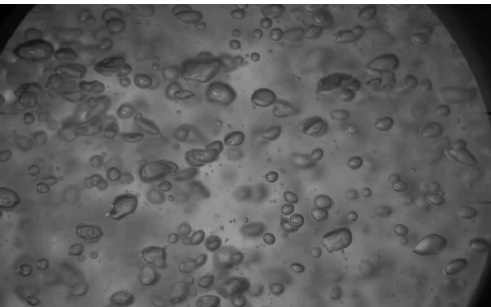
Figure 2. Sample image of the frame from F3 video described in Table 1 under consideration within the current study. Despite the filming of bubble flows being performed by means of the high-speed and high-resolution camera as well as with additional lighting, the flow’s specificity determined the complexity of the primary task, namely, marking and model